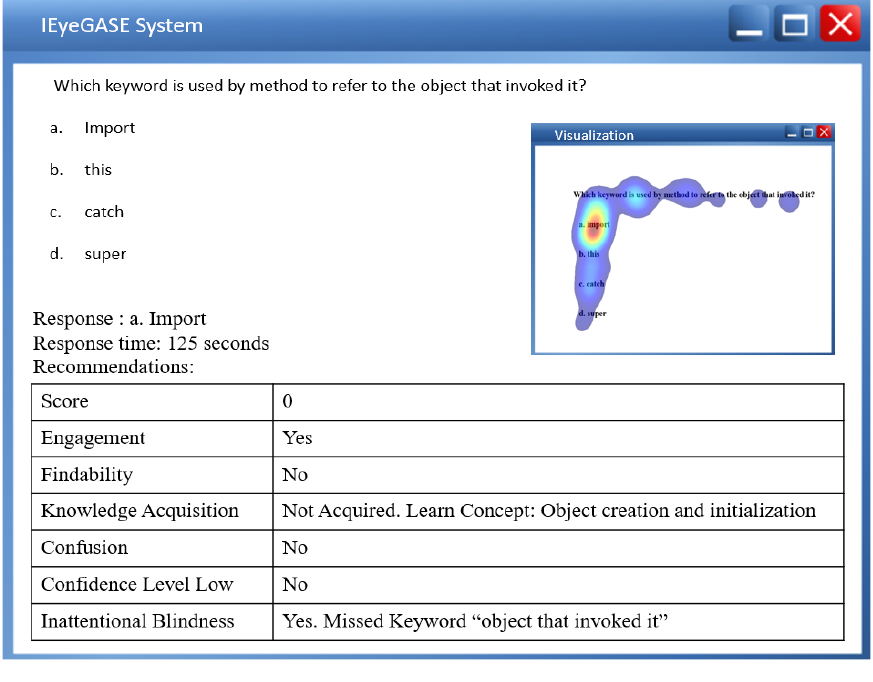
Figure 13. Personalized feedback of a poor learner.